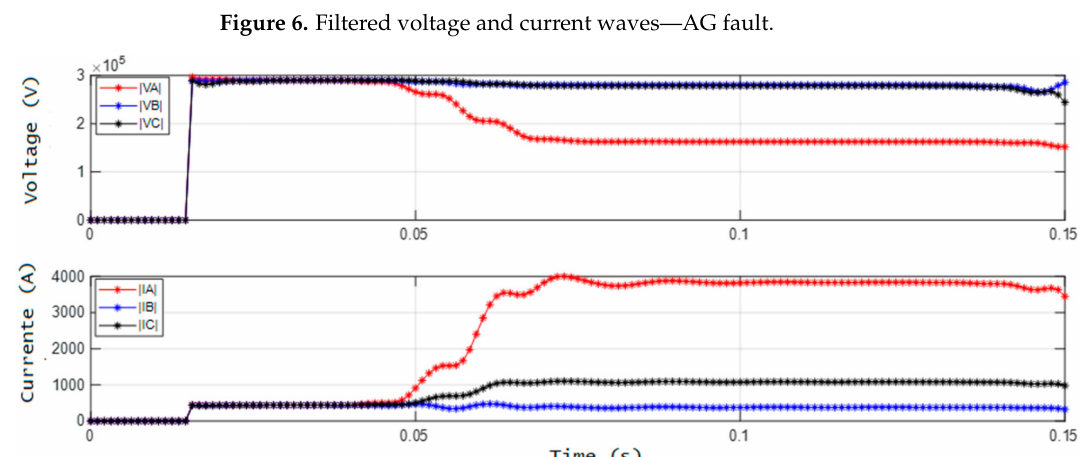
Figure 7. The amplitude of voltage and current phasors—AG